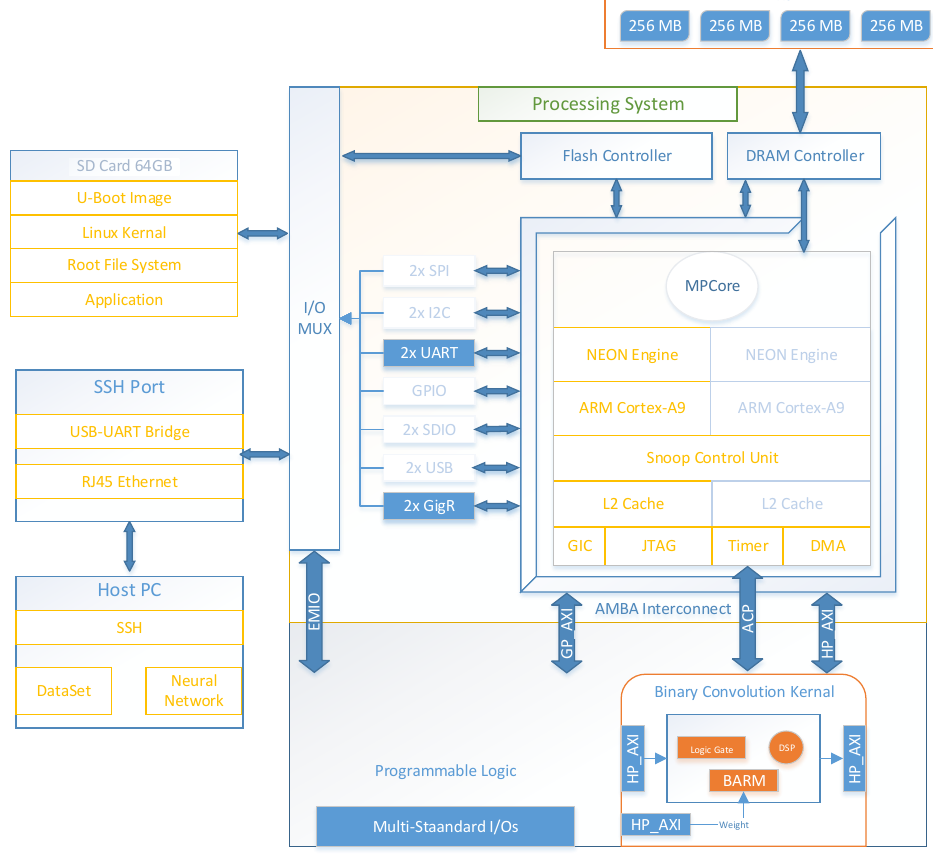
Figure A1. The hardware block diagram of the BNN implementation based on